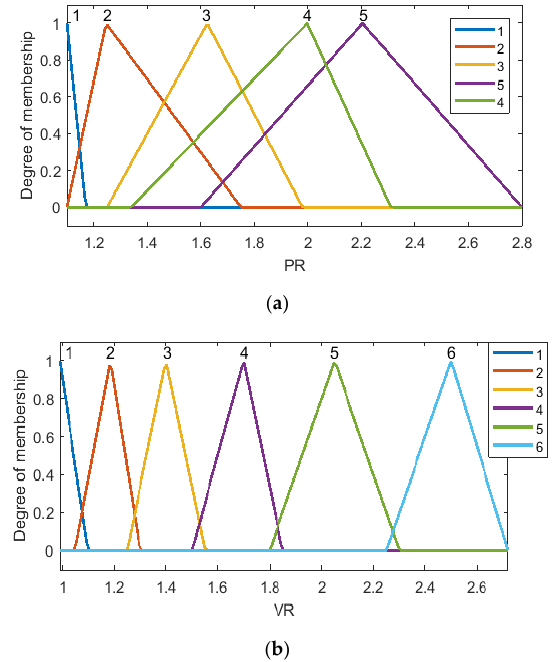
Figure 9. Membership functions of the minor fault model: ( a ) power rate, ( b ) voltage rate.